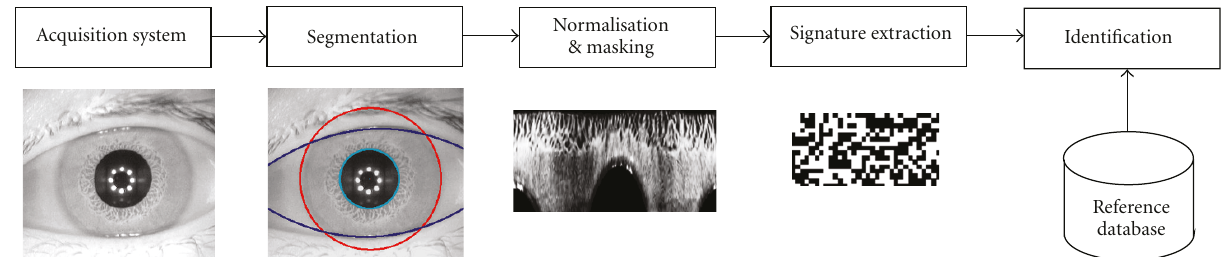
Figure 2: Functional scheme of the complete recognition system.